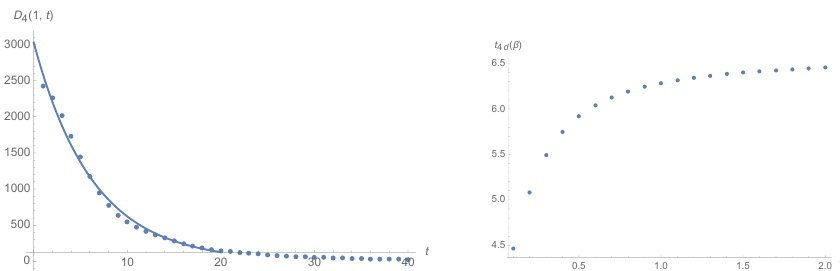
Figure 4. The exponential decay of the correlation function D 4 ( β , t ) as a function of time at ( β , t ) , D (cid:48)(cid:48) ( β , t ) , D (cid:48)(cid:48)(cid:48) ( β , t ) demonstrate a similar exponential decay β = 1. The rest of the functions D (cid:48) 4 4 4 ∼ exp ( − t ) . The temperature dependence of the exponent t ( β ) have a well defined high and low 4 t 4 ( β ) temperature limits and is shown at far right. The corresponding limiting values of the function t 4 ( β ) in dimensionless units are t 4 ( 0 ) = 0.112 and t 4 ( ∞ ) = 0.163. The behaviour of the exponent t 2 ( β ) of the two-point correlation function is shown in Figure 3.